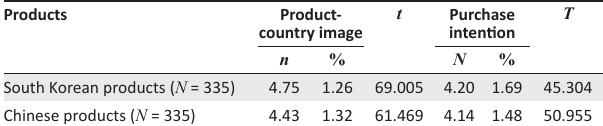
TABLE 3: Variance test results.